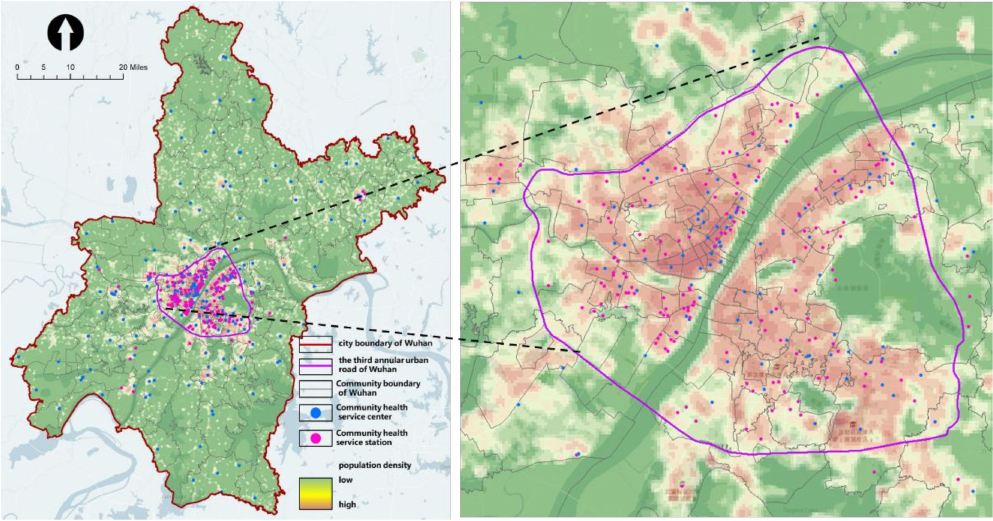
Figure 9. Heat map of the population during the COVID-19 pandemic in Wuhan City. The assessment results show that the community testing capacity in the main urban area is inadequate. In terms of the proportion of communities meeting the standards, 17 communities (shown in dark green) were able to complete the testing requirements within 3 days, covering only about 1% of the population. The 19 communities (in light green) that could complete the requirements in more than 3 days or less than 7 days, covering about 3% of the population. A sum of 109 communities with mild and moder- ate non-compliance (in light yellow) covered about 68% of the population. There were 38 communities with severe non-compliance (in dark yellow and red), covering about 49% of the population (Figure 10).